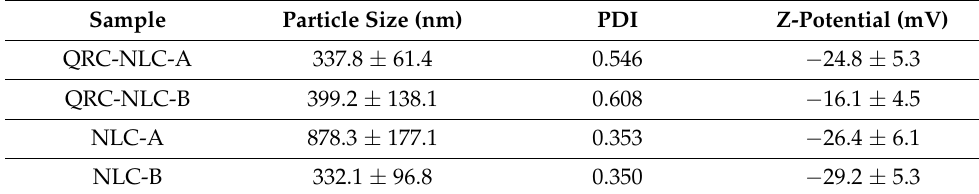
Table 6. Particle size (nm), PDI, and Z-potential (mV) ± SE of NLCs samples.